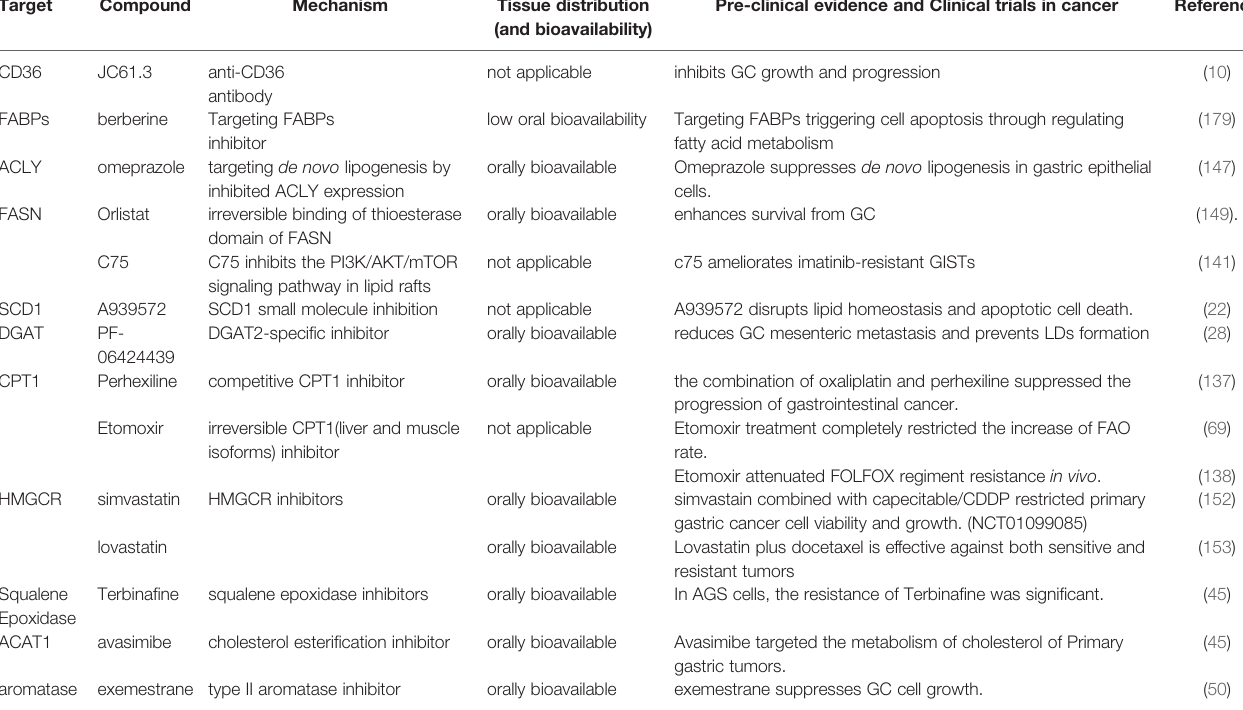
TABLE 4 | Summary of small-molecule inhibitors of lipogenic